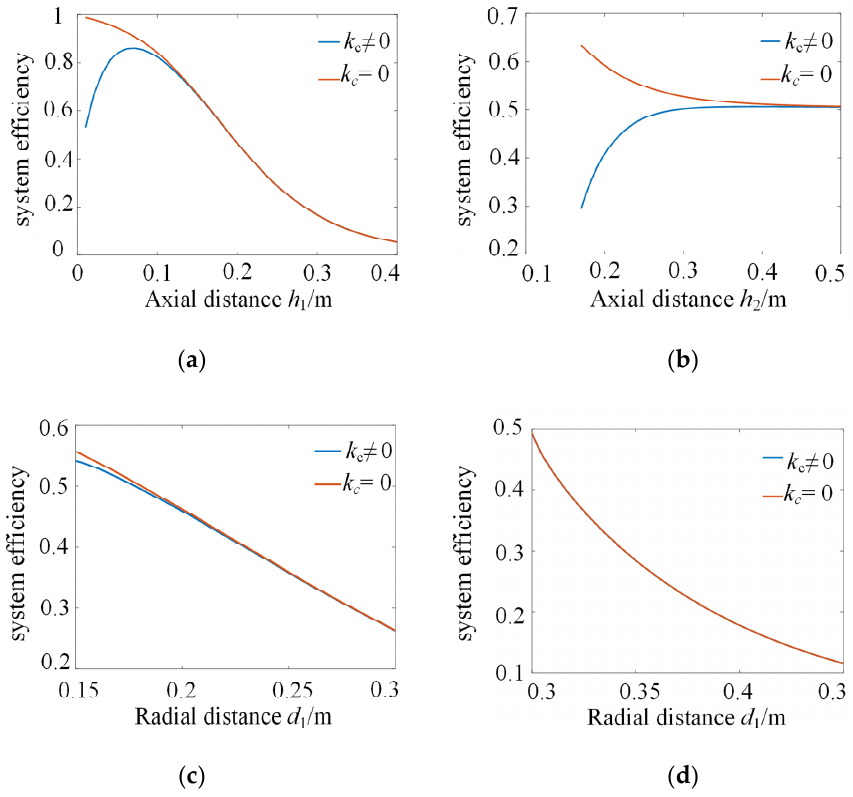
Figure 4. Cross-coupling analysis in four coupling cases. ( a ) Coaxial opposite side. ( b ) Coaxial same side. ( c ) Different axes same side. ( d ) Different axis coplanar.